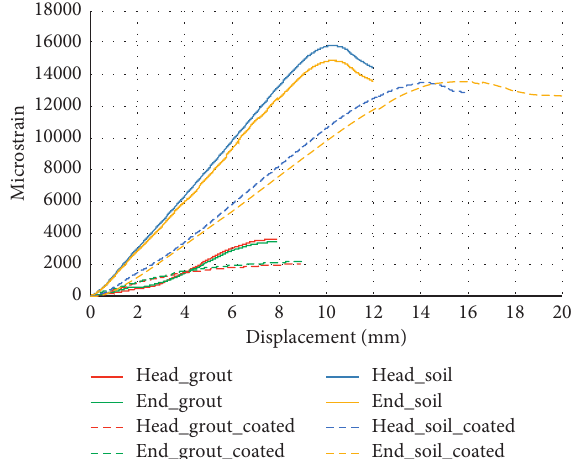
Figure 27: Strain vs. displacement at head and endpoints for uncoated and coated GFRP rock bolt sensors.